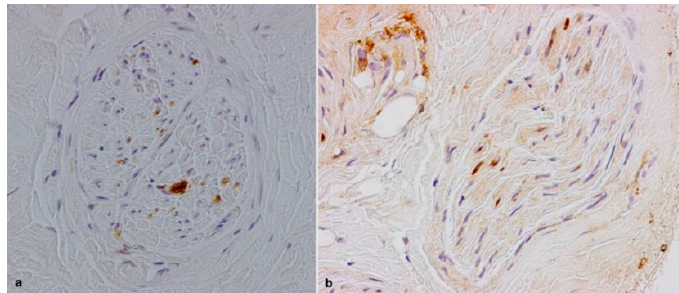
Figure 4. Sural nerve biopsies from a 61 ‐ year ‐ old Val32Ala ( a ) and from a 74 ‐ year ‐ old Val30Met ( b ) hATTR patients. Macrophages are depicted by CD68 ( a ). Some T lymphocytes are labelled by CD3 ( b ).